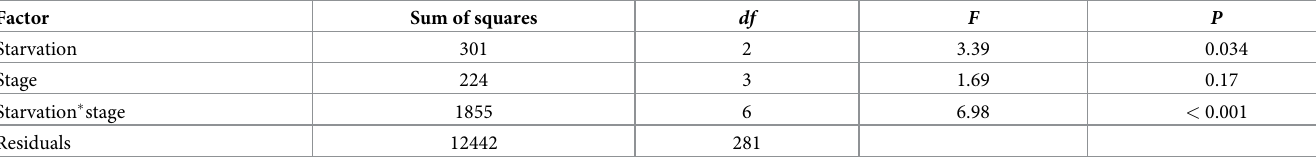
Table 1. Effect of starvation and stage on total distance moved in the laboratory experiment.